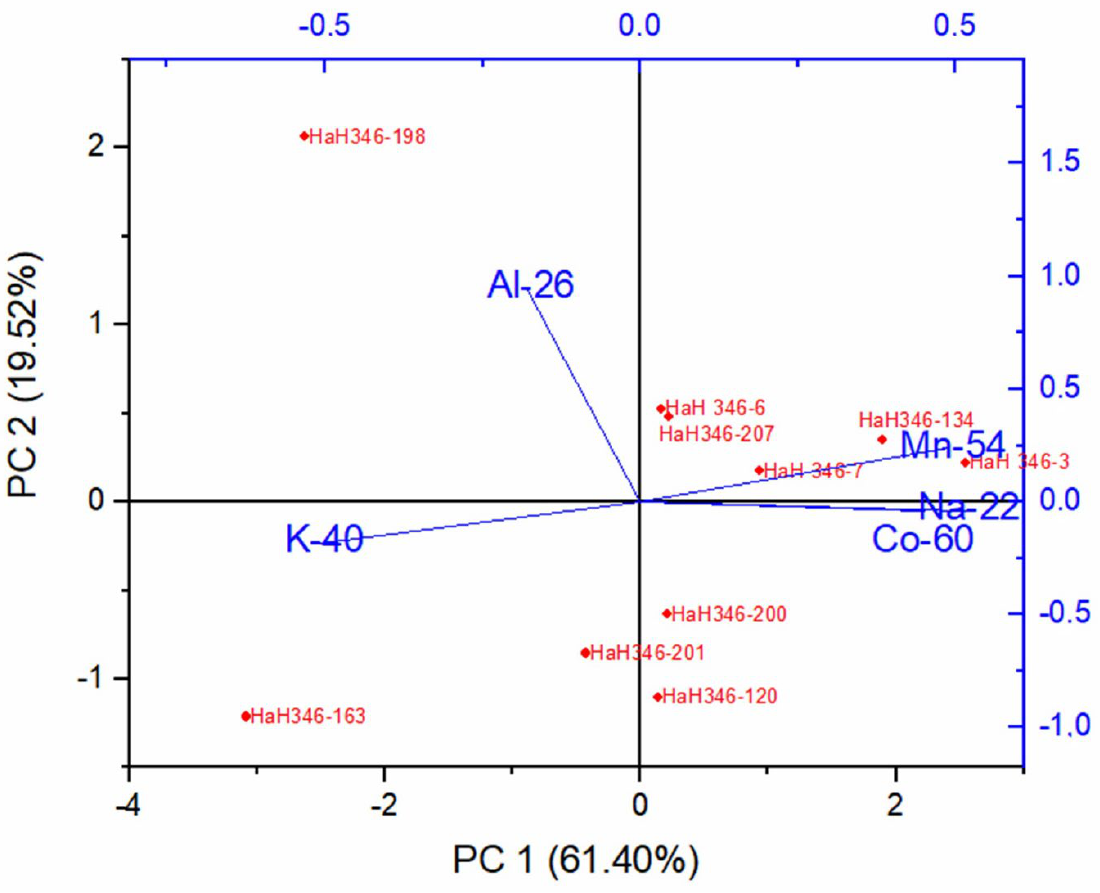
Figure 7. PCA analysis results. Table 4. Extracted